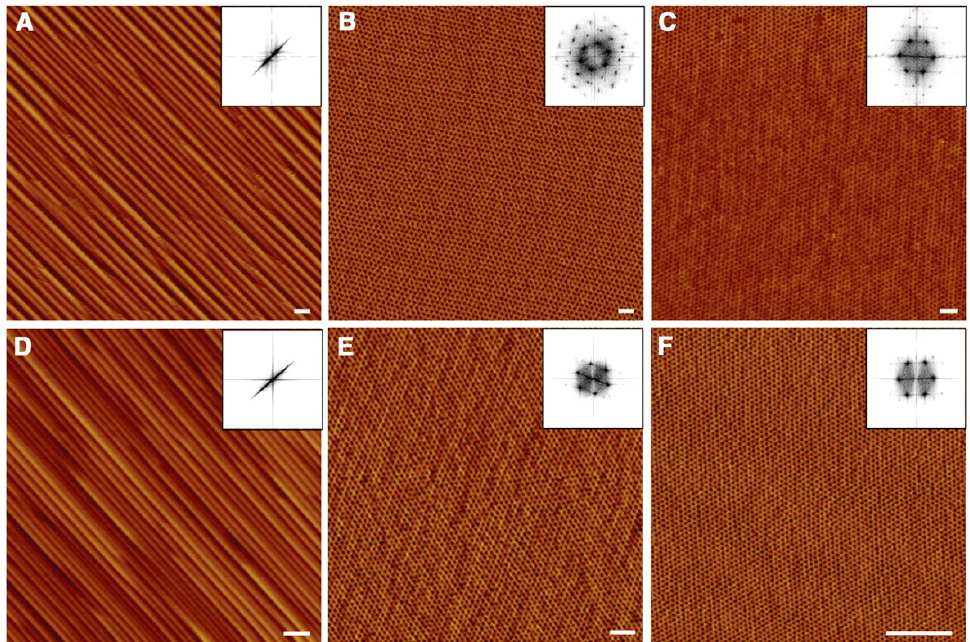
Figure 18. Atomic force microscopy (AFM) height images of sawtooth patterns and phase images of solvent-annealed PS- b -PEO thin films. ( A , D ) When the M-plane sapphire was annealed at 1400 °C and 1500 °C, a pitch of ~48 and ~24 nm and a peak-to-valley depth of ~6 and ~3 nm were obtained, respectively. Highly ordered PEO cylindrical microdomains having areal densities of 0.74 to 10.5 terabit/inch2 from PS- b -PEO ( M n = 26.5 kg/mol) ( B ), PS- b -PEO ( M n = 25.4 kg/mol) ( C ), PS- b -PEO ( M n = 21.0 kg/mol) ( E ), and PS- b -PEO ( M n = 7.0 kg/mol) ( F ) BCP thin films annealed in o-xylene vapor were obtained. Scale bars, 100 nm. Reprinted from Reference [123]. (Copyright (2009) American Association for the Advancement of Science).